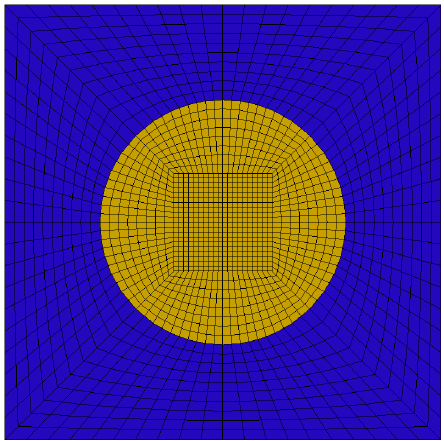
Figure 1. FE mesh of a Unit Cell discretised using M = 1840 elements with quadratic Ansatz functions resulting in N u = 14,882 and N y = 7441 DoFs.